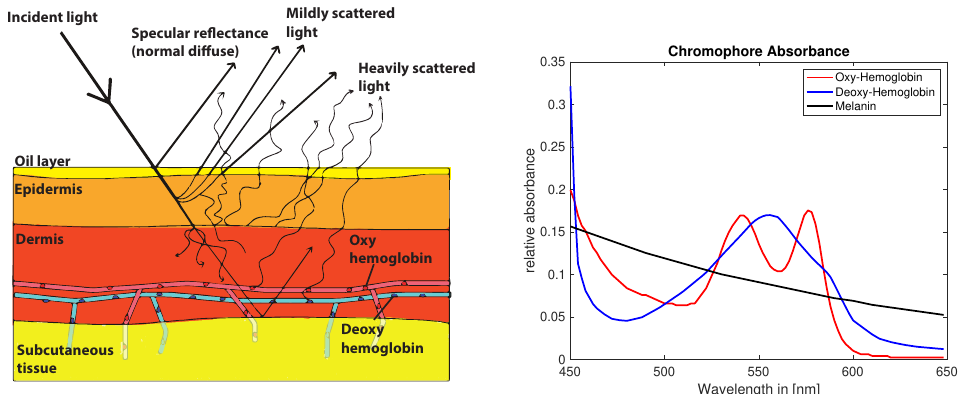
Figure 2. Skin light interaction simplified model ( left ) [43]. Absorption of common chromophores in the visual range of the light spectrum ( right ) (data compiled from [44], Figure recreated from [43].).